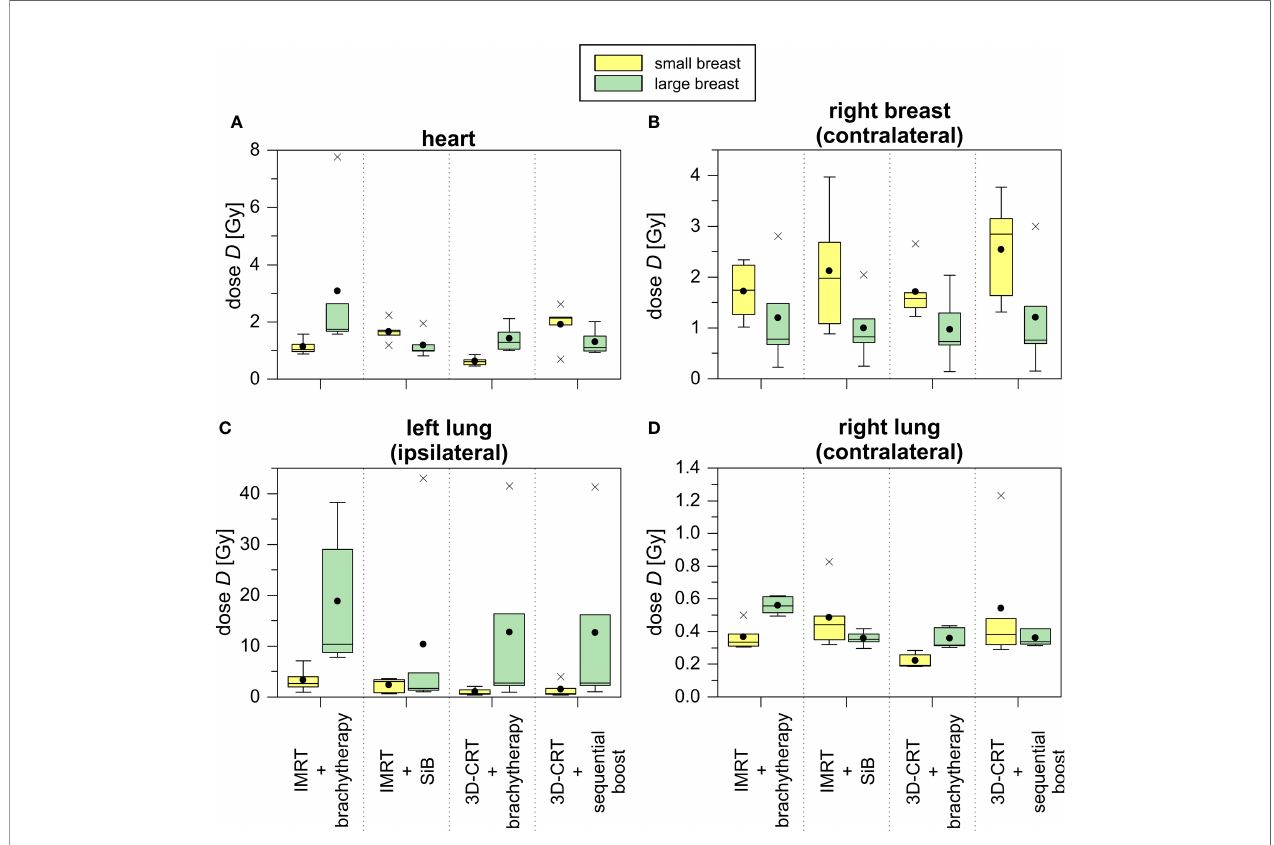
FIGURE 8 | TLD measurements of treatment plans concerning the representative small (yellow) and large (green) breast treatment plans for all scenarios depicted as boxplots. The TLDs were located in the heart (A) , the contralateral breast (B) , the ipsilateral (C) and contralateral (D)